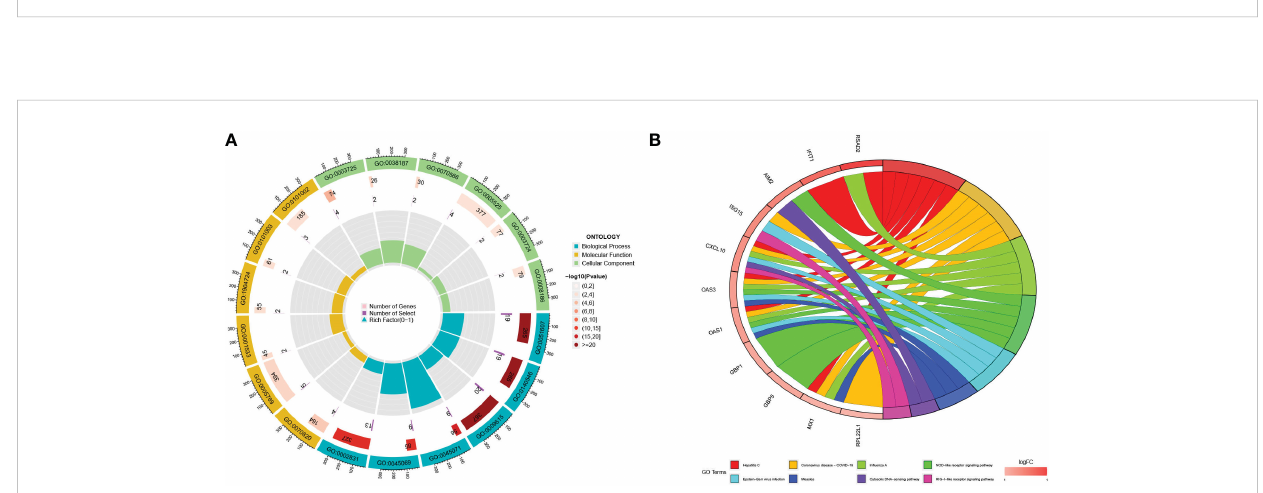
FIGURE 4 The functional enrichment analyses of DEGs. (A) The GO analyses results for DEGs; (B) The KEGG analysis results for